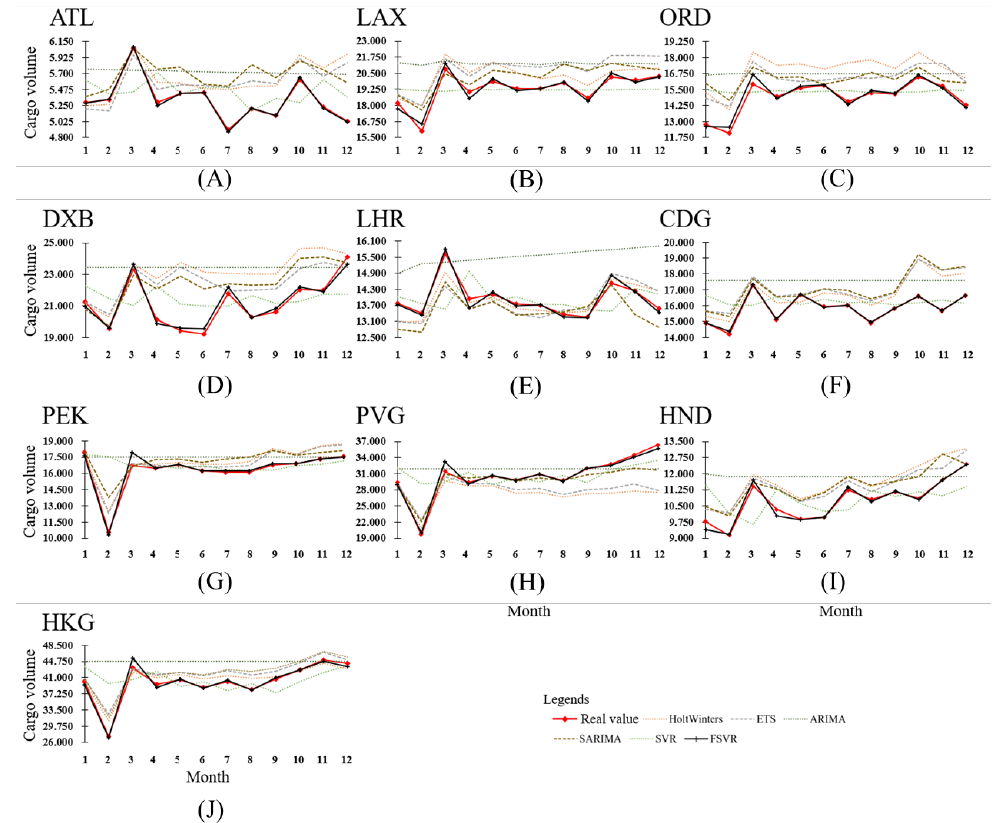
Figure 1. The forecast results of the freight volume of each airport from January to December 2019: ( A ) ATL Atlanta; ( B ) LAX Los Angeles; ( C ) ORD O’Hare; ( D ) DXB Dubai; ( E ) LHR London Heathrow; ( F ) CDG Paris Charles de Gaulle; ( G ) PEK Beijing Capital; ( H ) PVG Shanghai Pudong; ( I ) HND Tokyo Haneda; ( J ) HKG Hong Kong.